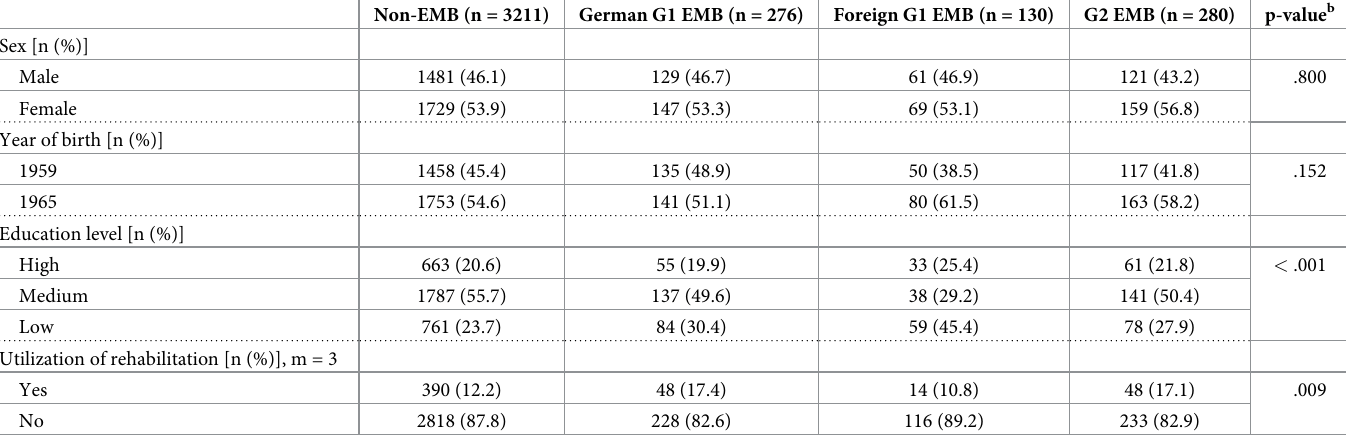
Table 2. Characterization of study population (weighted sample a , n =